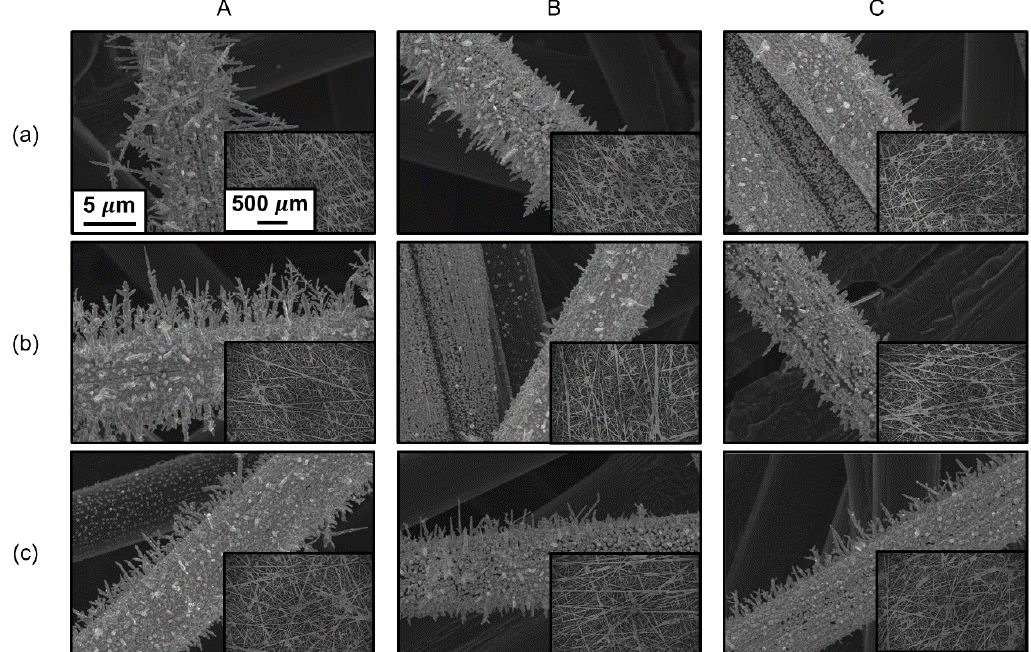
Figure 8. FE-SEM images of the fabricated 25.5 cm 2 Ag GDE (Figure 7) according to the position on the electrode. Ag deposition was performed at 0.83 mA/cm 2 for 5 min with different working-counter electrode distances: ( a ) 1 cm, ( b ) 2 cm, and ( c ) 4 cm.